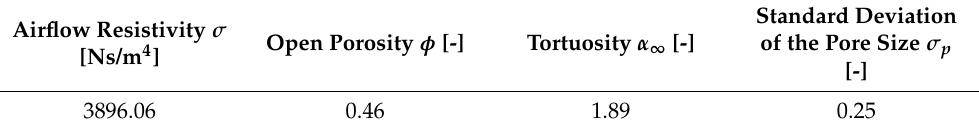
Standard Deviation